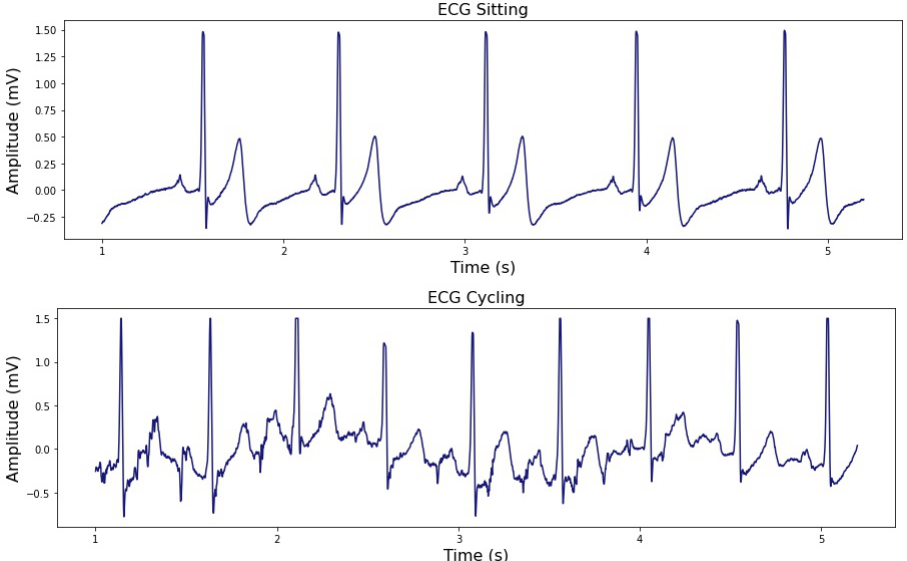
Figure 1. Five-second window of an ECG signal related to “Sitting” and “Cycling” activities per- formed by one